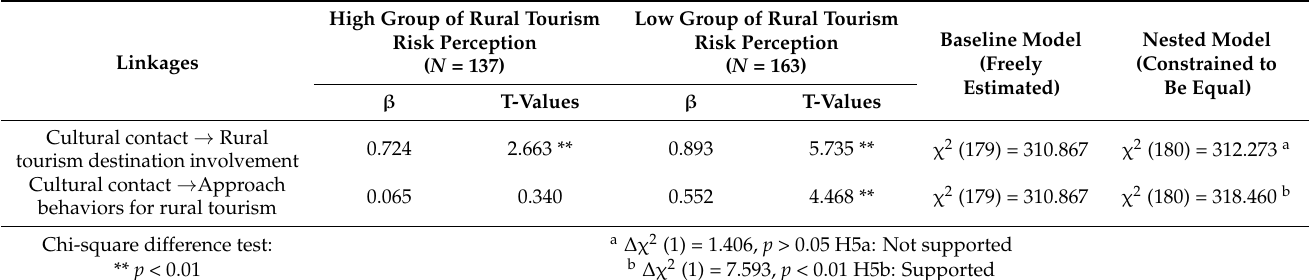
Table 5. Result of the invariance model